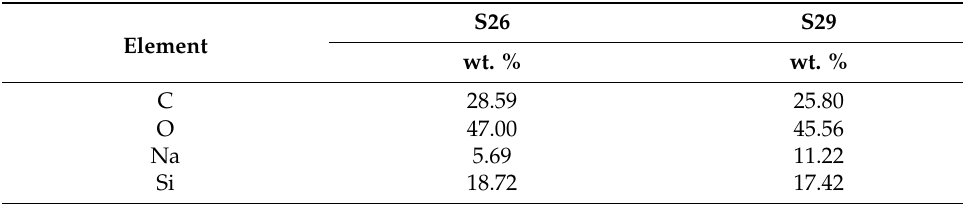
Table 8. EDX results after the fire resistance test.